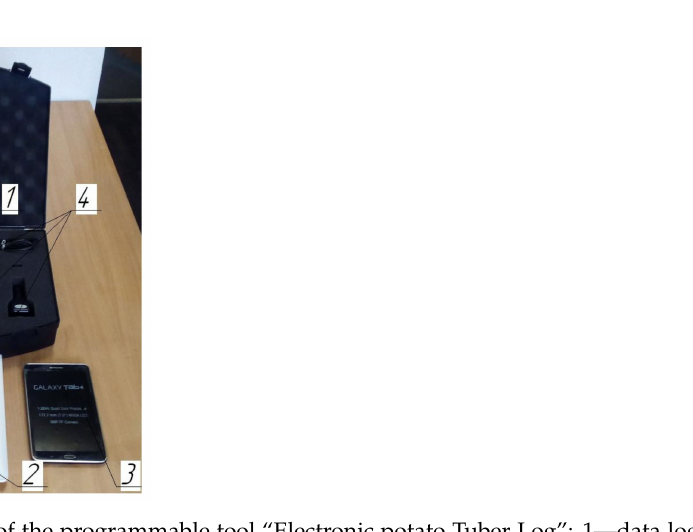
Figure 3. General view of the programmable tool “Electronic potato Tuber Log”: 1—data logger; 2—computer; 3—tablet computer; 4—auxiliary